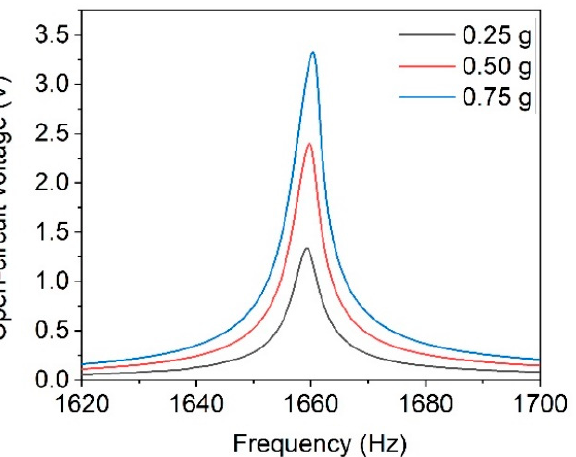
Figure 18. Open-circuit voltage in dependence of excitation frequency of design 3 harvester at varying excitation